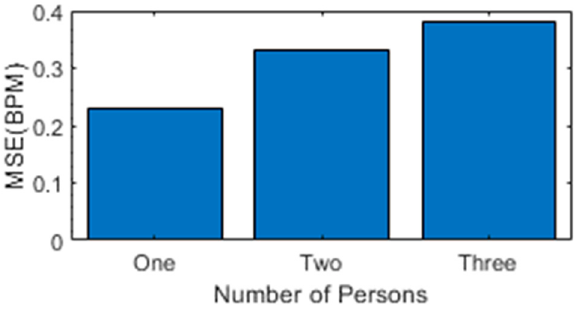
Figure 12. Mean absolute error vs. number of persons.